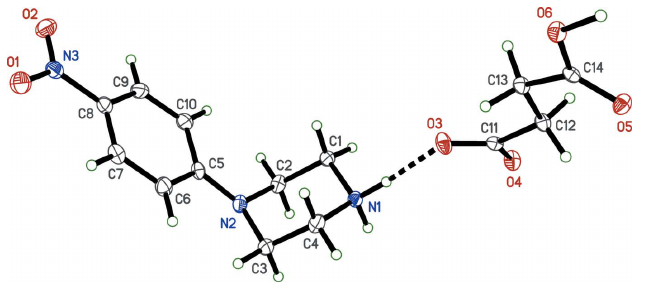
Figure 4 The molecular structure (50% displacement ellipsoids) of IV . Hydrogen atoms are shown as arbitrary circles. The dashed line indicates a hydrogen